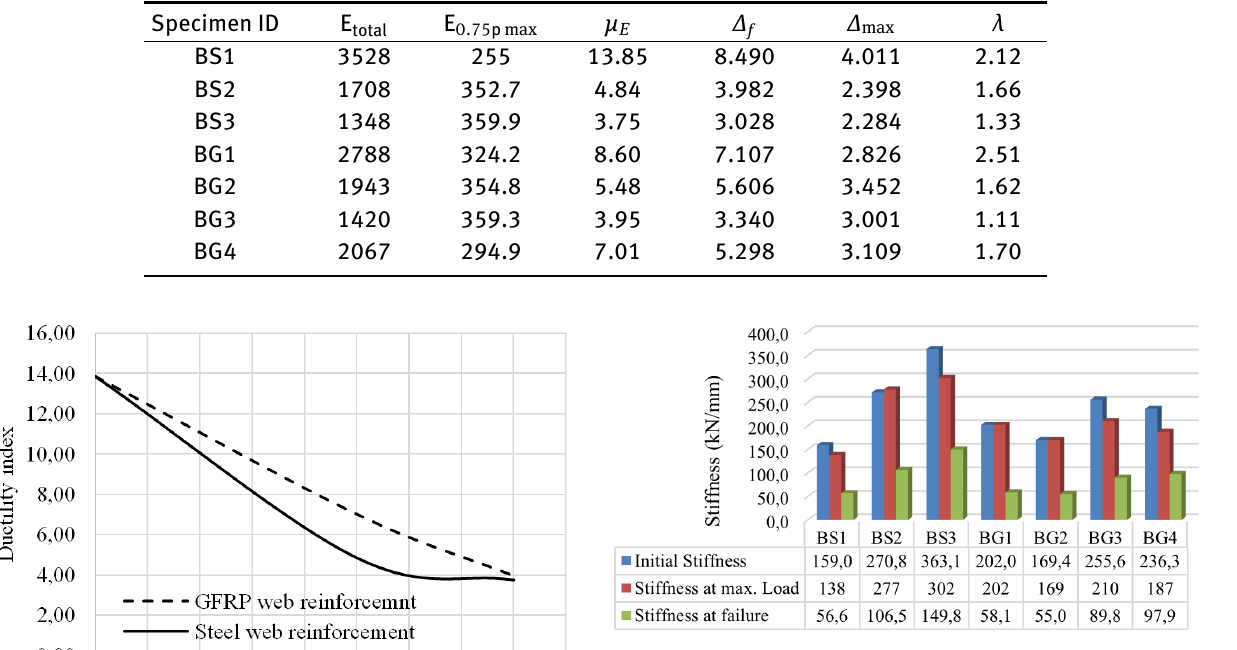
Figure 10: Stiffness of the deep beam specimens